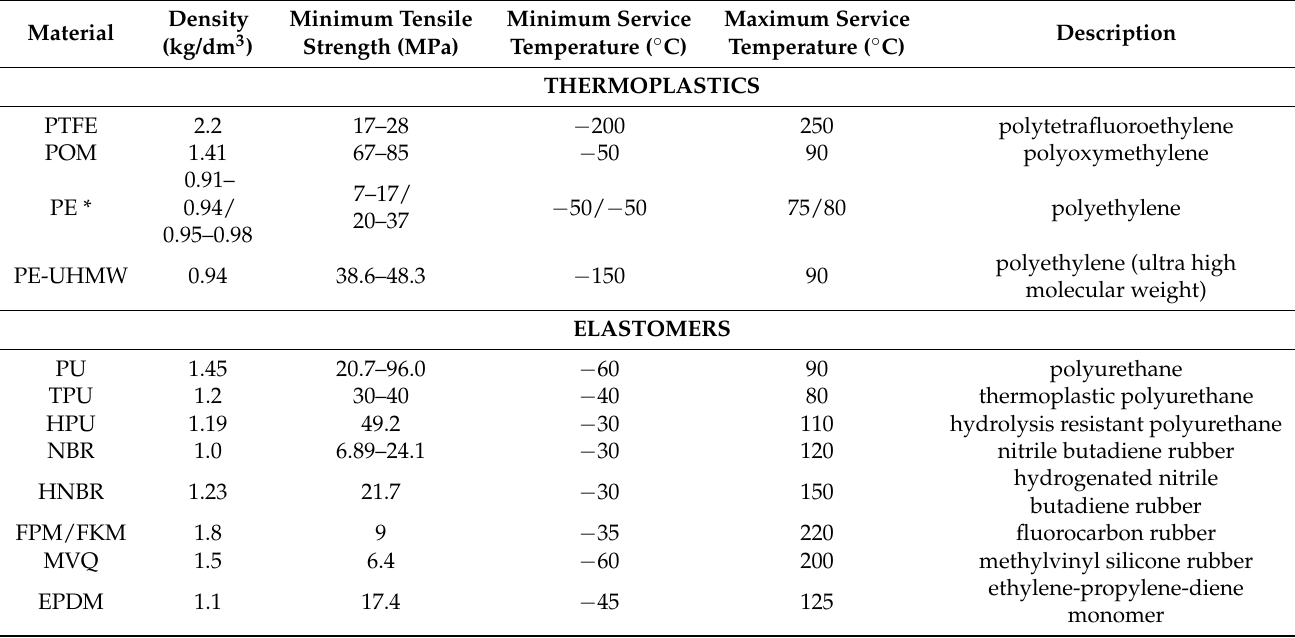
Table 9. Basic properties of the materials used for sealing